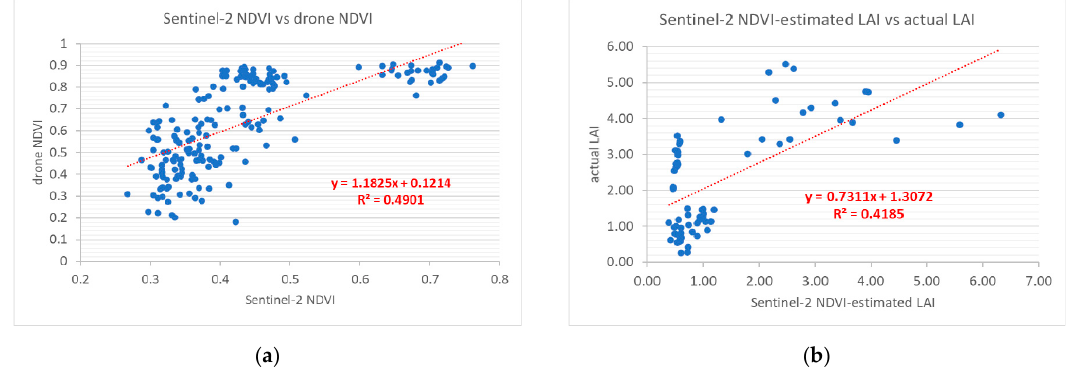
Figure 13. A two-step conversion relationship from Sentinel–2 NDVI to ( a ) drone NDVI and ( b ) actual LAI, with a total R 2 = 0.4185. Sentinel–2 NDVI were highly dispersed at values < 0.5, yielding poor conversion in the first step and affecting the overall performance.